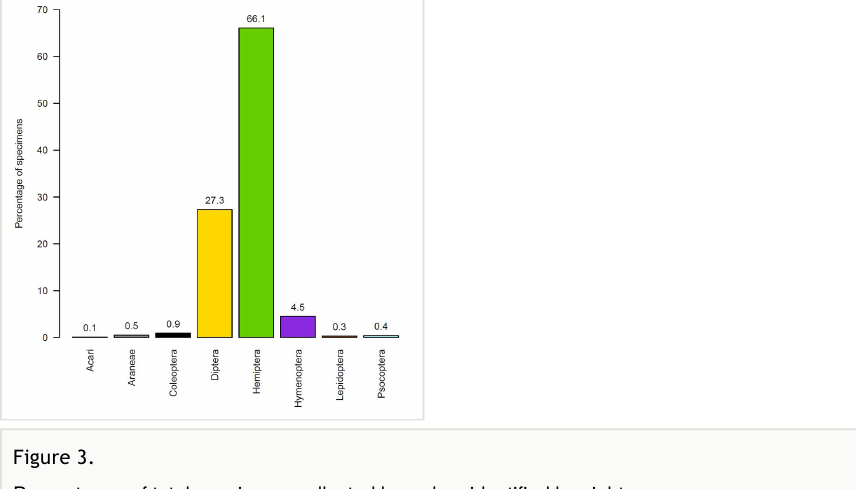
Percentages of total specimens collected by orders identi fi ed by sight.